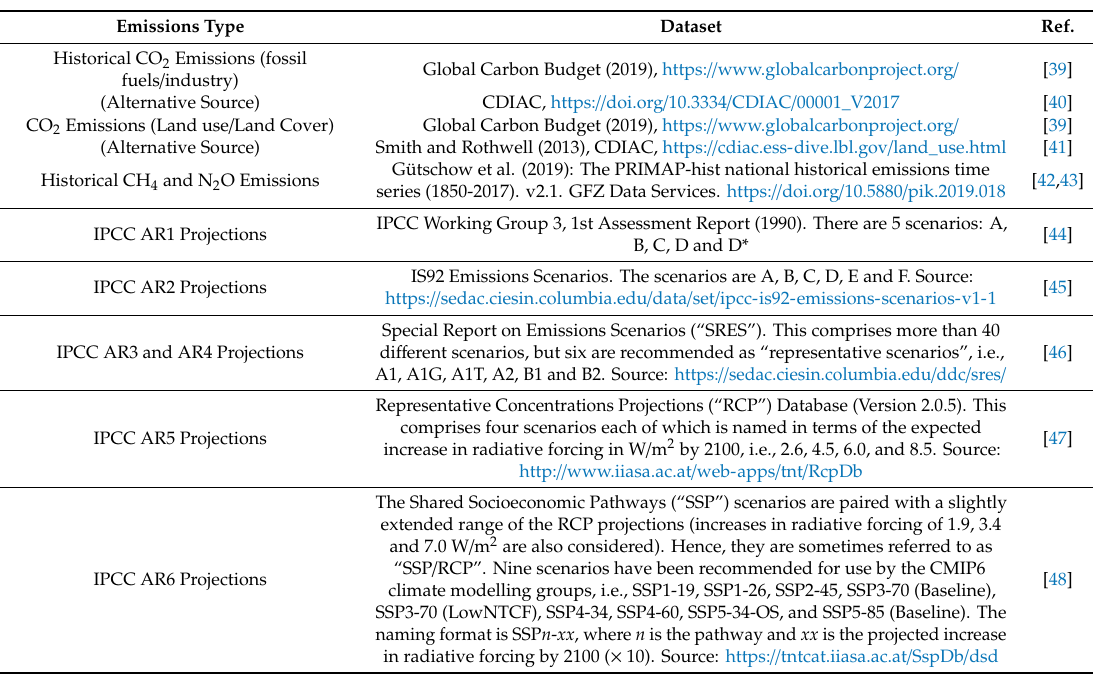
Table 2. Sources used in this study for emissions